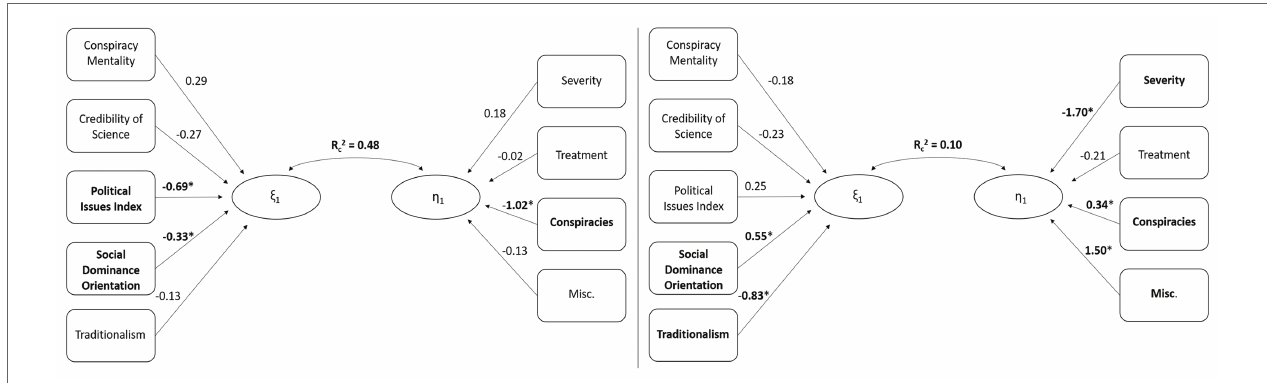
FIGURE 1 | Diagram of the two significant canonical models. Substantial contributors to the synthetic predictor variate ( ξ ) and criterion variate ( η ) are bolded and noted with * . The squared canonical correlations ( R 2 c ) are significant at the p < 0.001 level. Left panel : More alignment with liberal policy positions and a low social dominance orientation (SDO) predict a low willingness to share conspiracy theories about COVID-19 on social media. Right panel : A high SDO and a low endorsement of traditionalism predict a low willingness to share misinformation on social media related to the severity and spread of COVID-19, but a high willingness to share conspiracies about COVID-19 and miscellaneous cultural misinformation about